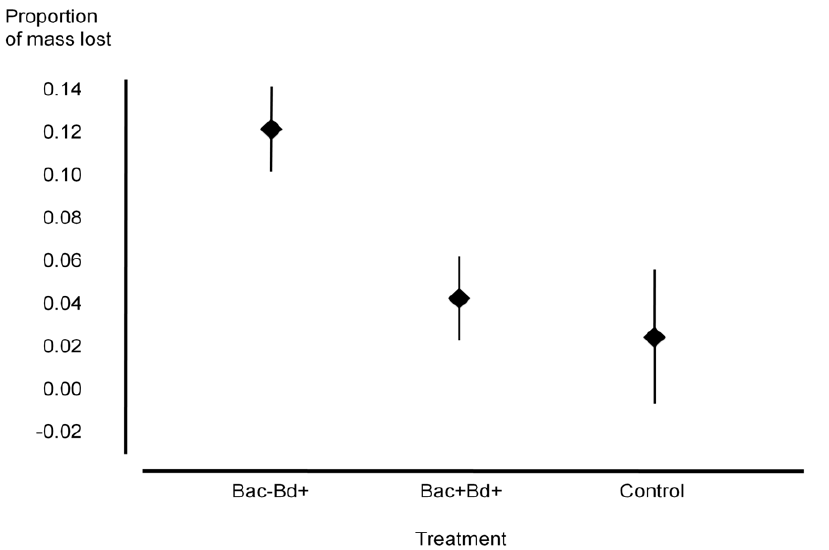
Figure 1. Proportion of body mass lost over a period of 55 days for treatments Bac 2 Bd + ( n =20), Bac + Bd + ( n =20), and controls (Bac 2 Bd 2 and Bac + Bd 2 , n =11). Error bars represent 6 1 standard error.